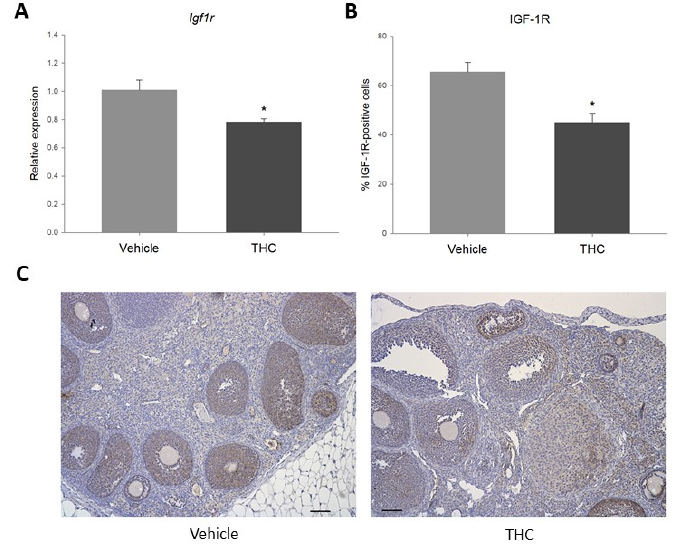
Figure 3. ( A ). Relative expression of Igf1r in prenatally THC-exposed adult rat ovaries. ( B ). Percentage of IGF-1R-positive ovarian follicular cells in prenatally THC-exposed adult rat ovaries. ( C ). IGF-1R protein levels in prenatally THC-exposed adult rat ovaries (mean + SEM; N = 5, * p < 0.05). 2.4. Prenatal Exposure to THC Increases Follicular Apoptosis in the Adult Ovary It has previously been established that IGF-1/IGF-1R signaling plays an essential role in follicular growth and atresia, mostly by regulating granulosa cell proliferation and apoptosis [58]. Considering that gestational exposure to THC resulted in a significant decrease in IGF-1R, the expression of the apoptotic marker caspase-3 was evaluated. As shown in Figure 4, while there were no changes in the steady-state mRNA expression of Casp3 , gestational exposure to THC significantly increased the percentage of cleaved caspase-3-positive ovarian follicular cells.